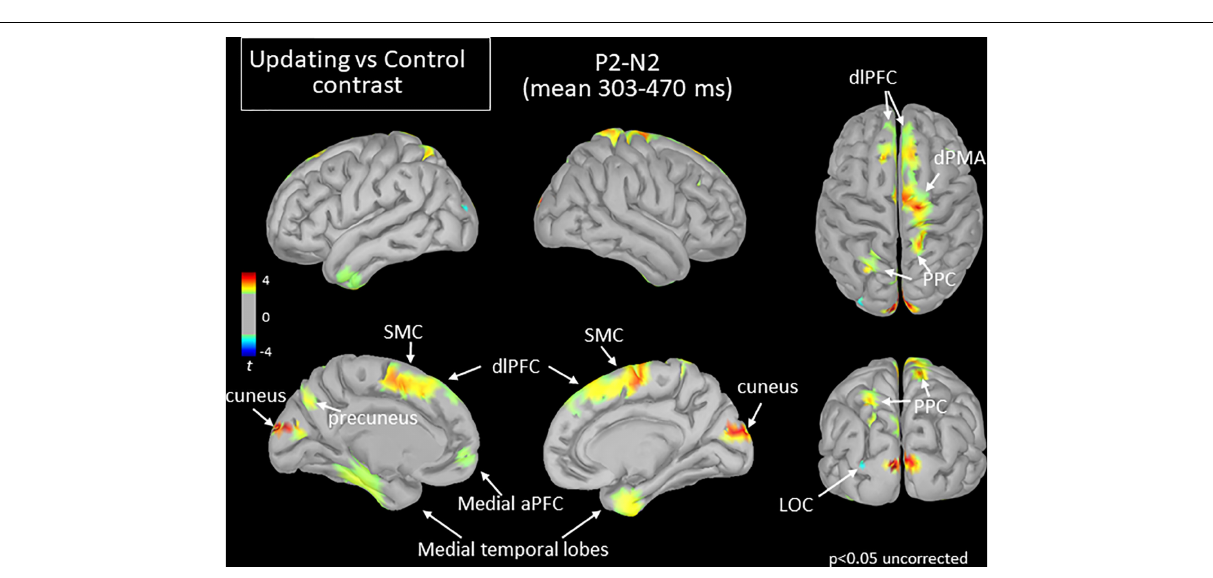
FIGURE 7 | Statistical map (cortex only, p < 0.05 uncorrected) for the Updating vs. Control contrast computed during the P 2 N 2 component of the RotEP. The t -test analysis did not reveal significant effect when correcting for multiple comparisons (FDR correction). aPFC, anterior prefrontal cortex; dlPFC, dorsolateral prefrontal cortex; dPMA, dorsal premotor area; LOC, lateral occipital cortex; PPC, posterior parietal cortex; SMC, supplementary motor